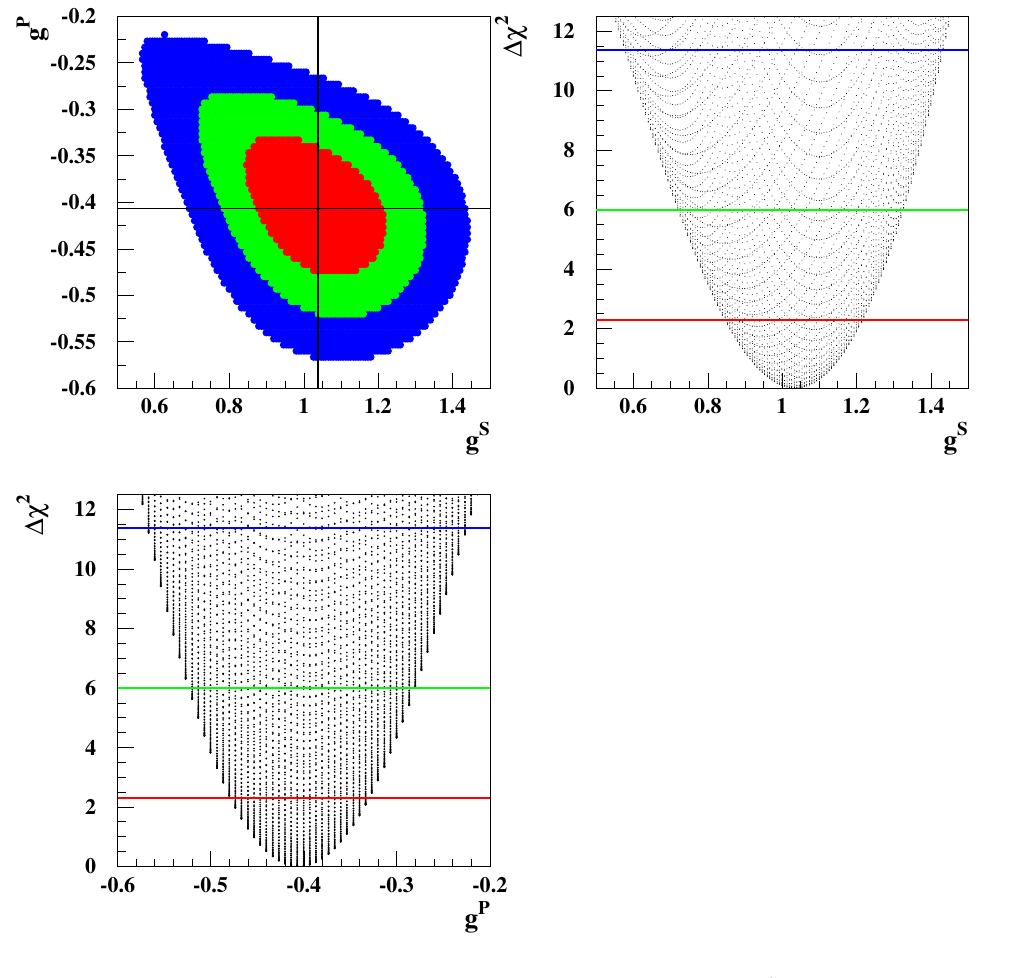
Figure 4 . The same as in (cid:12)gure 3 but taking scenario S6 :